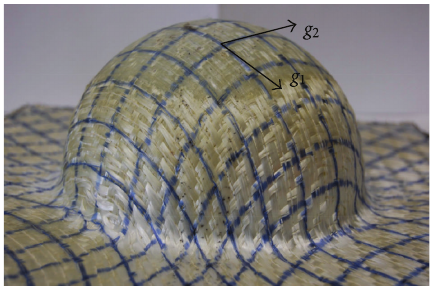
F 11: Fibres deformation during the forming